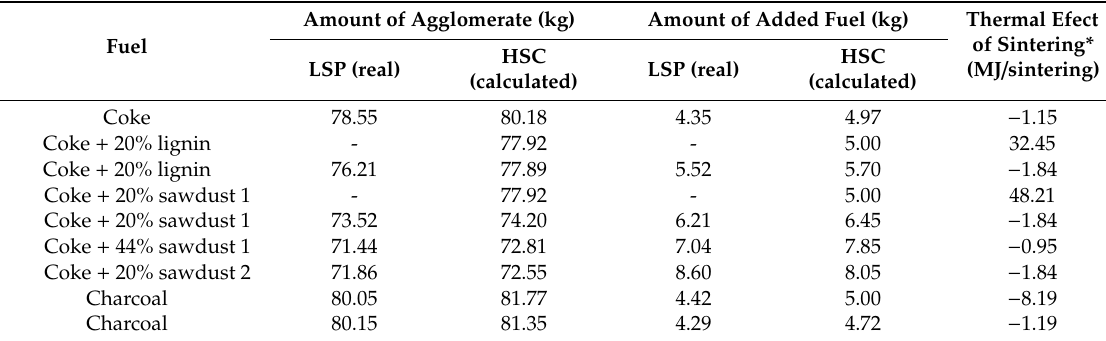
Table 8. Selected parameters of mass and thermal balance of agglomerate production (calculation for 100 kg of charge).